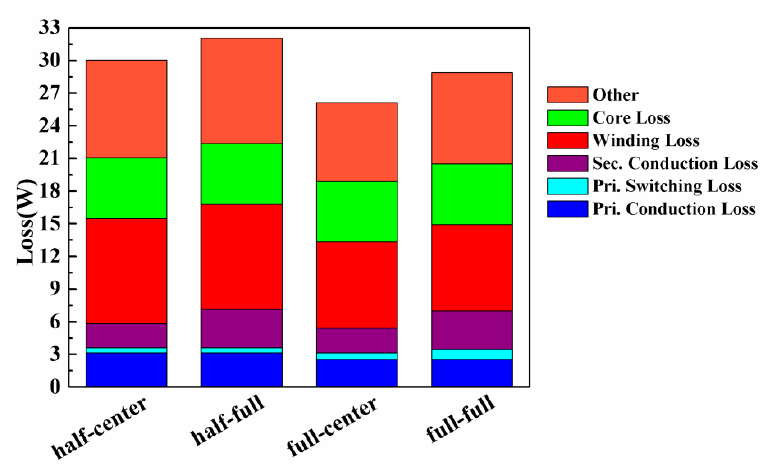
Figure 4. Comparison of loss types in different architectures.